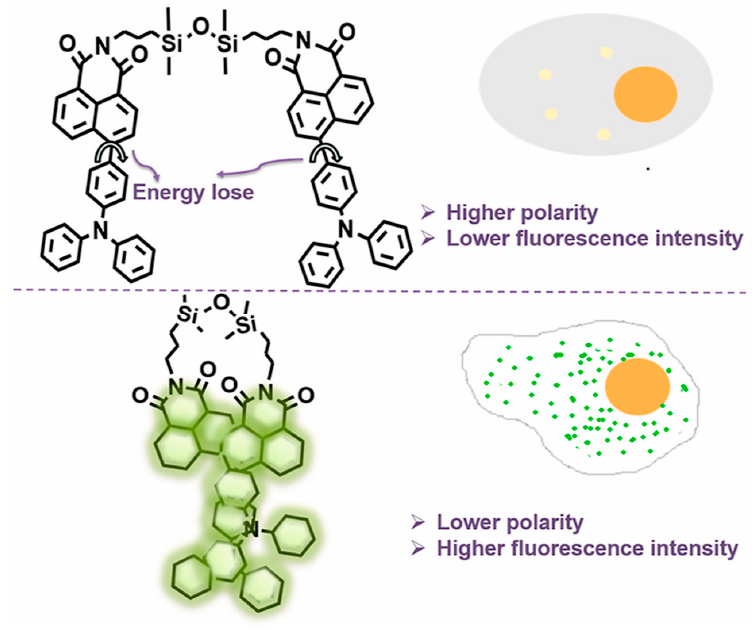
Figure 4. The structure of TDCQ [36] . Copyright 2021, Elsevier.